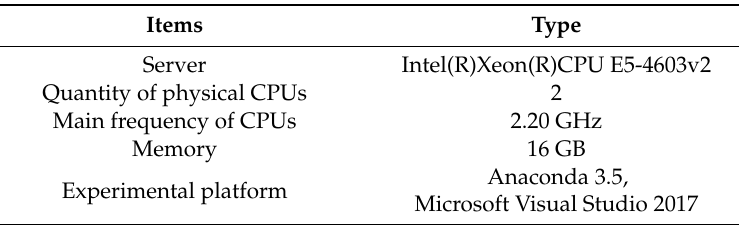
Table 2. Experimental